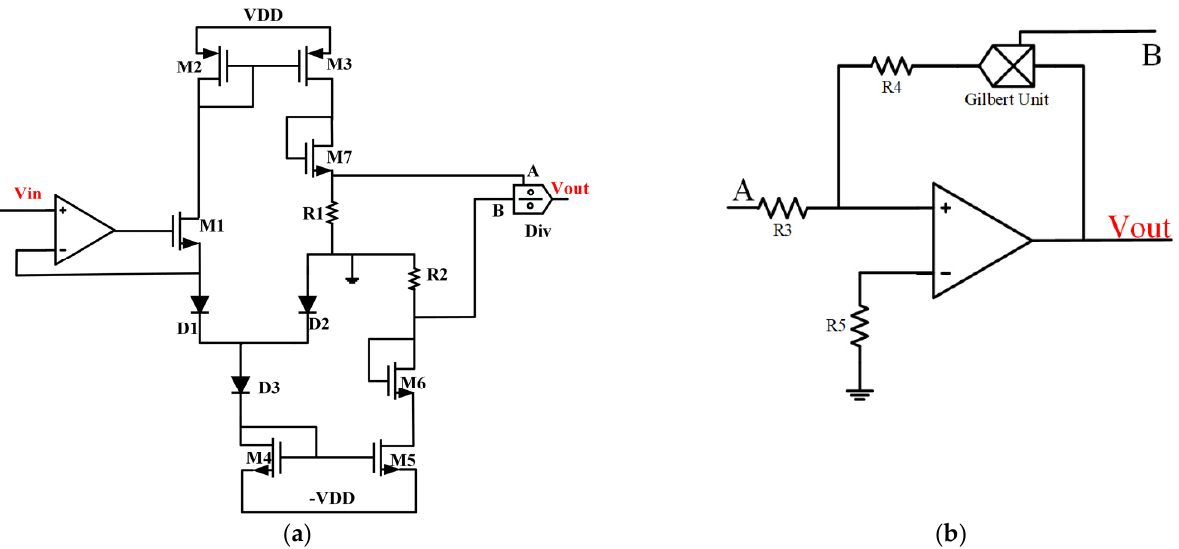
Figure 4. ( a ) The overall circuit architecture of the high-precision sigmoid, with R1 = R2, the size of M4 is equal to the size of M5 and so are M2 and M3. ( b ) Details of the structure of the analog divider.